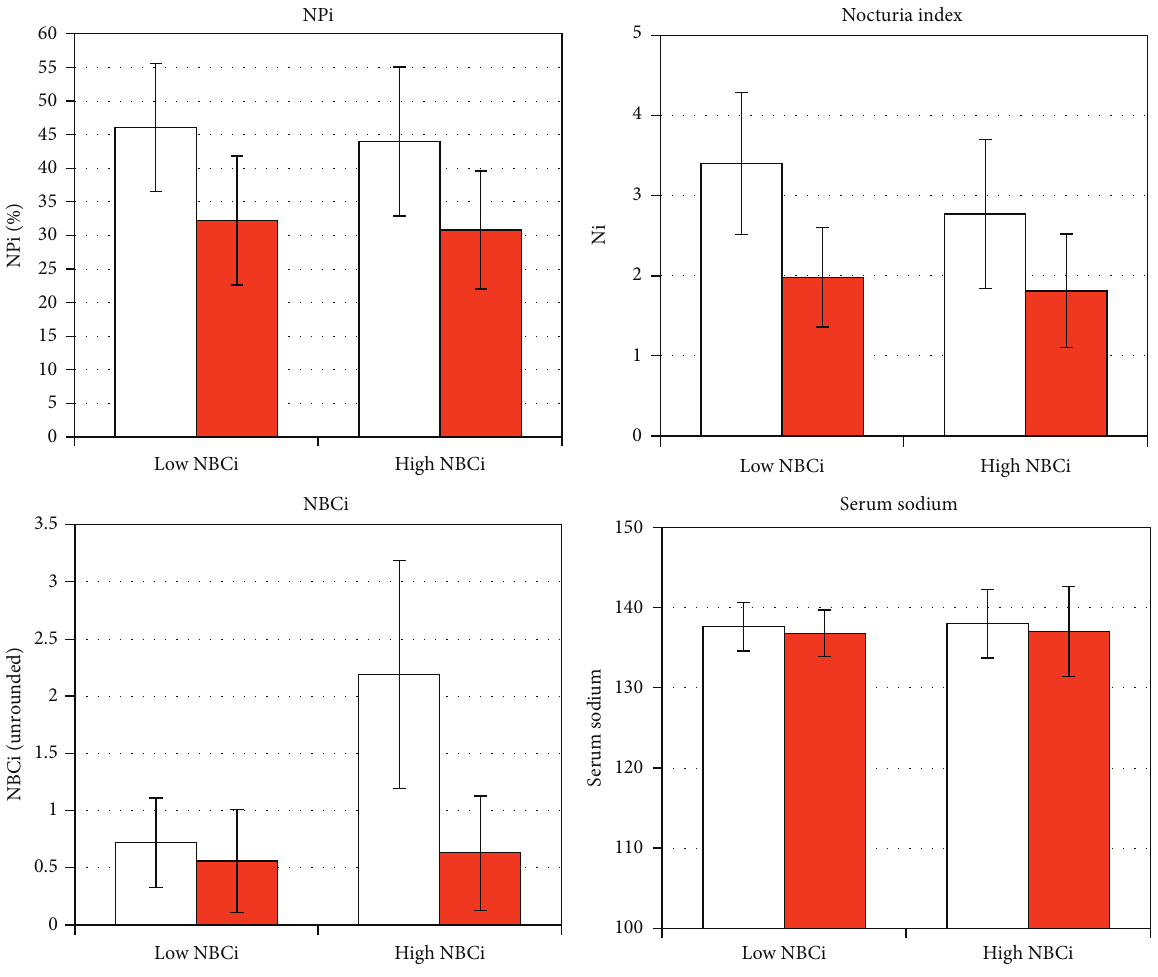
Figure 2: Effect of desmopressin therapy according to normal or high pre-treatment nocturnal bladder capacity index (NBCi) on nocturnal polyuria index (NPi), nocturia index (Ni), NBCi, and serum sodium. Each pair: first column—before therapy, second column—on therapy. Pre- versus on-therapy values for NPi and Ni were statistically significantly different with 𝑃 < 0.0001 . NBCi in normal pre-treatment NBCi group remained the same on treatment ( 𝑃 = 0.28 ) and decreased significantly in high pre-treatment group ( 𝑃 < 0.0001 ). Regarding serum sodium, there were no difference between pre-treatment and on-treatment values, for high NBCi group 𝑃 = 0.93 , for normal NBCi group 𝑃 = 0.066 . On therapy, comparison of each two groups showed no significant differences for all four measures.